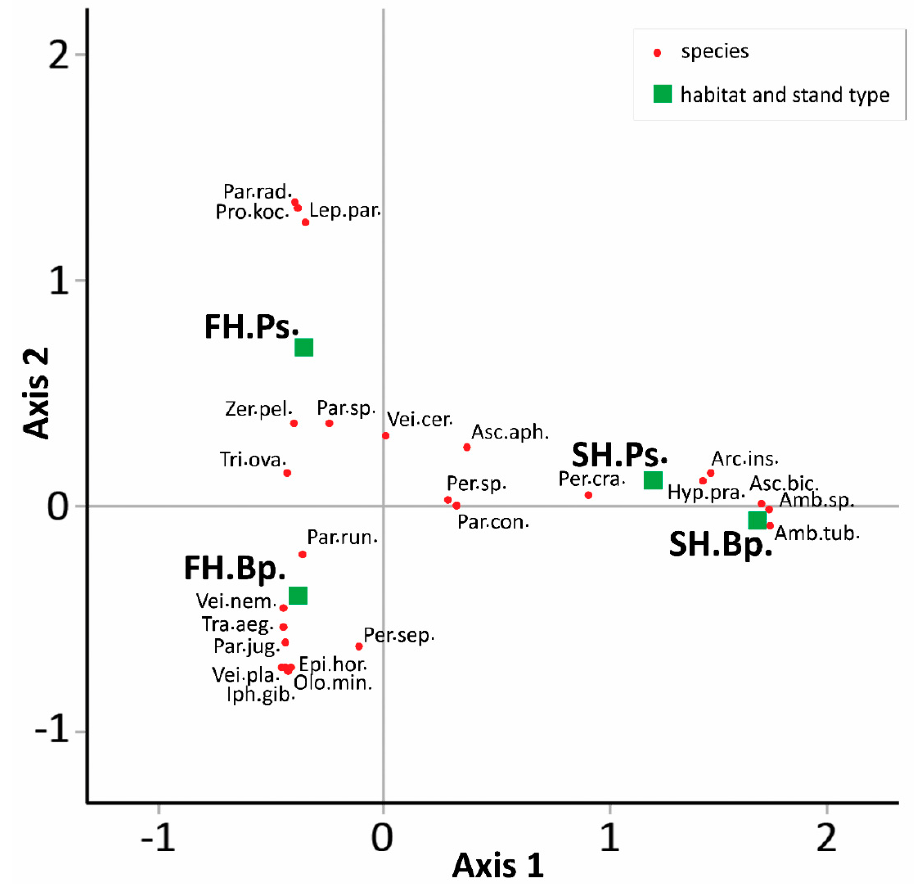
Figure 4. Correspondence analysis (CA) ordination diagram for the 25 most numerous mite taxa (N > 10). Habitat types are separated along Axis 1, while stands types are separated along Axis 2.